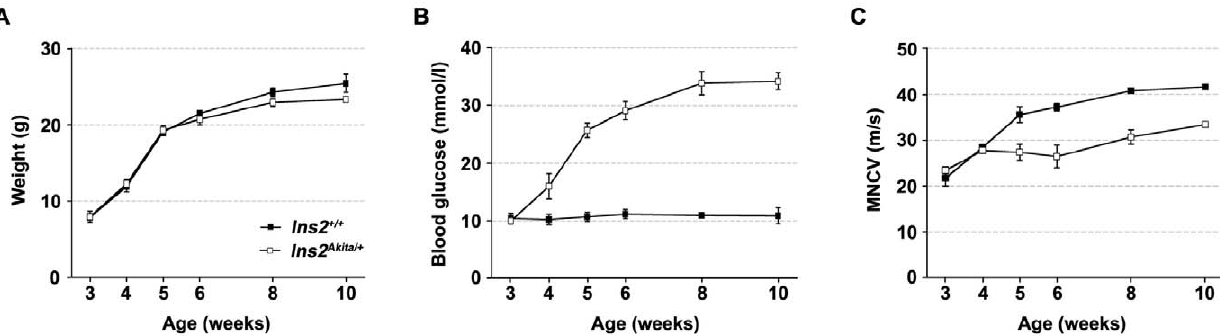
Figure 1. Phenotypic characterization of Ins2 Akita// + mice. Body weight ( A ), tail vein blood glucose ( B ) and motor nerve conduction velocity (MNCV, C ) were measured at depicted time-points in Ins2 Akita/ + and Ins2 + / + mice. All results are expressed as the mean 6 standard error of the mean (S.E.M.). ( Ins2 + / + : n=4; Ins2 Akita/ + : n=4).